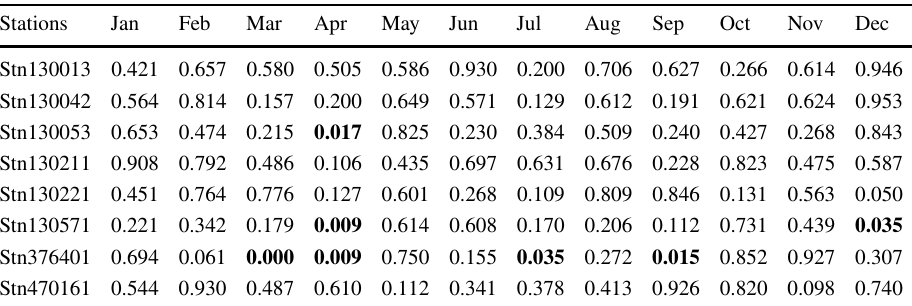
Bold number represents p < 0.05 indicating inhomogeneity in the corresponding time series at a 5% signifi-